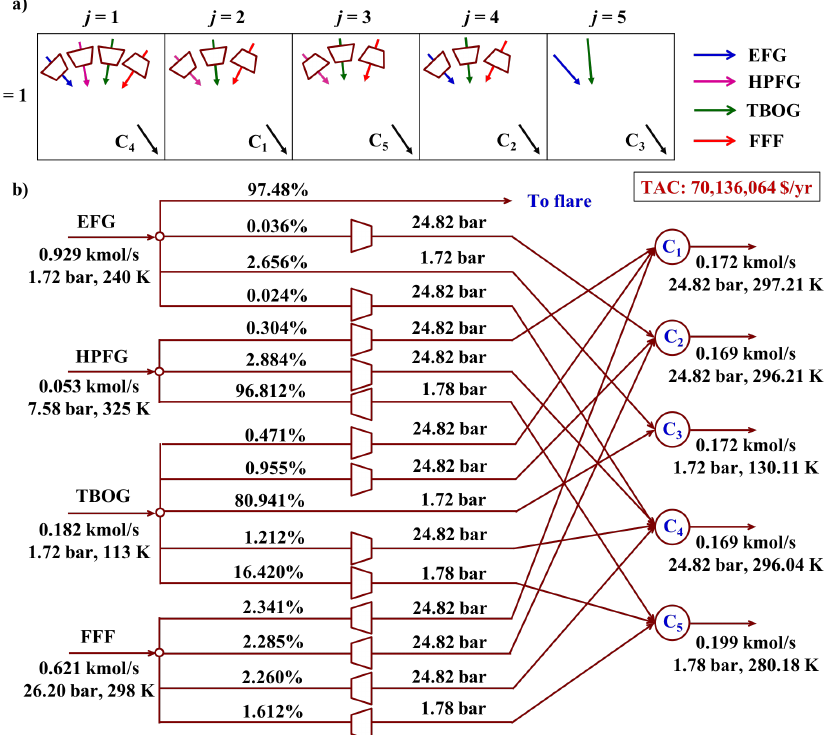
Figure 7. Block representation and process flowsheet for the optimal solution of FGN without intermediate pools: ( a ) Block representation for the optimal solution of FGN; ( b ) process flowsheet for the optimal solution of